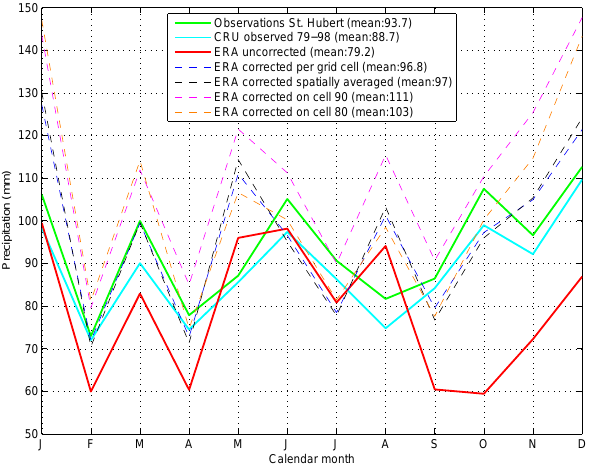
Fig. 4. Mean monthly temperature of the observations and (un)corrected datasets for the period